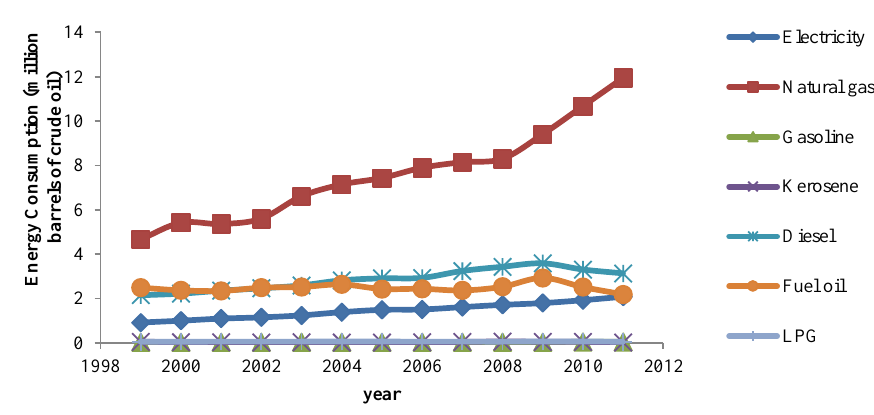
Figure 3. The amount of energy consumption over a period of 13 years in the food and beverage industries of